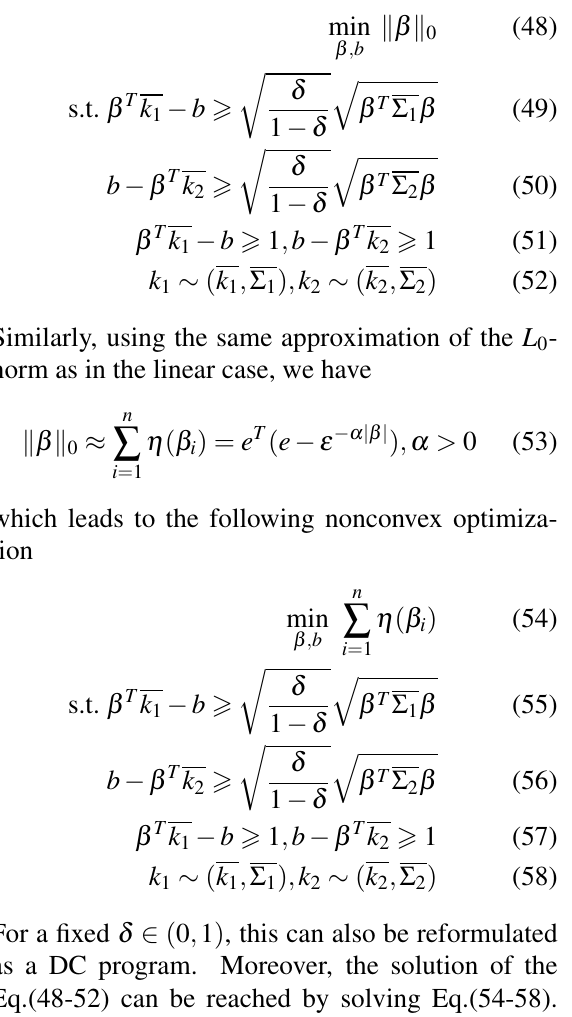
Table 1. The description of